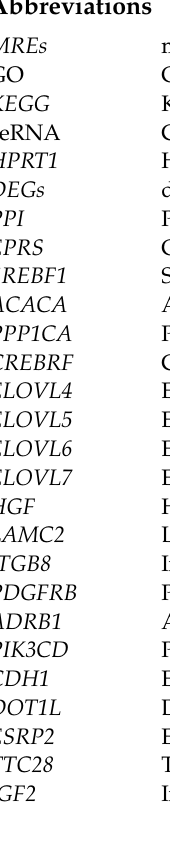
annotation file of Small RNA. Table S3: The information of Novel RNA. Table S4: The TPM value of miRNA. Table S5: The differential expression of miRNA. Table S6: The GO terms of enriched. Table S7: The KEGG pathway of enriched. Table S8: The information of protein